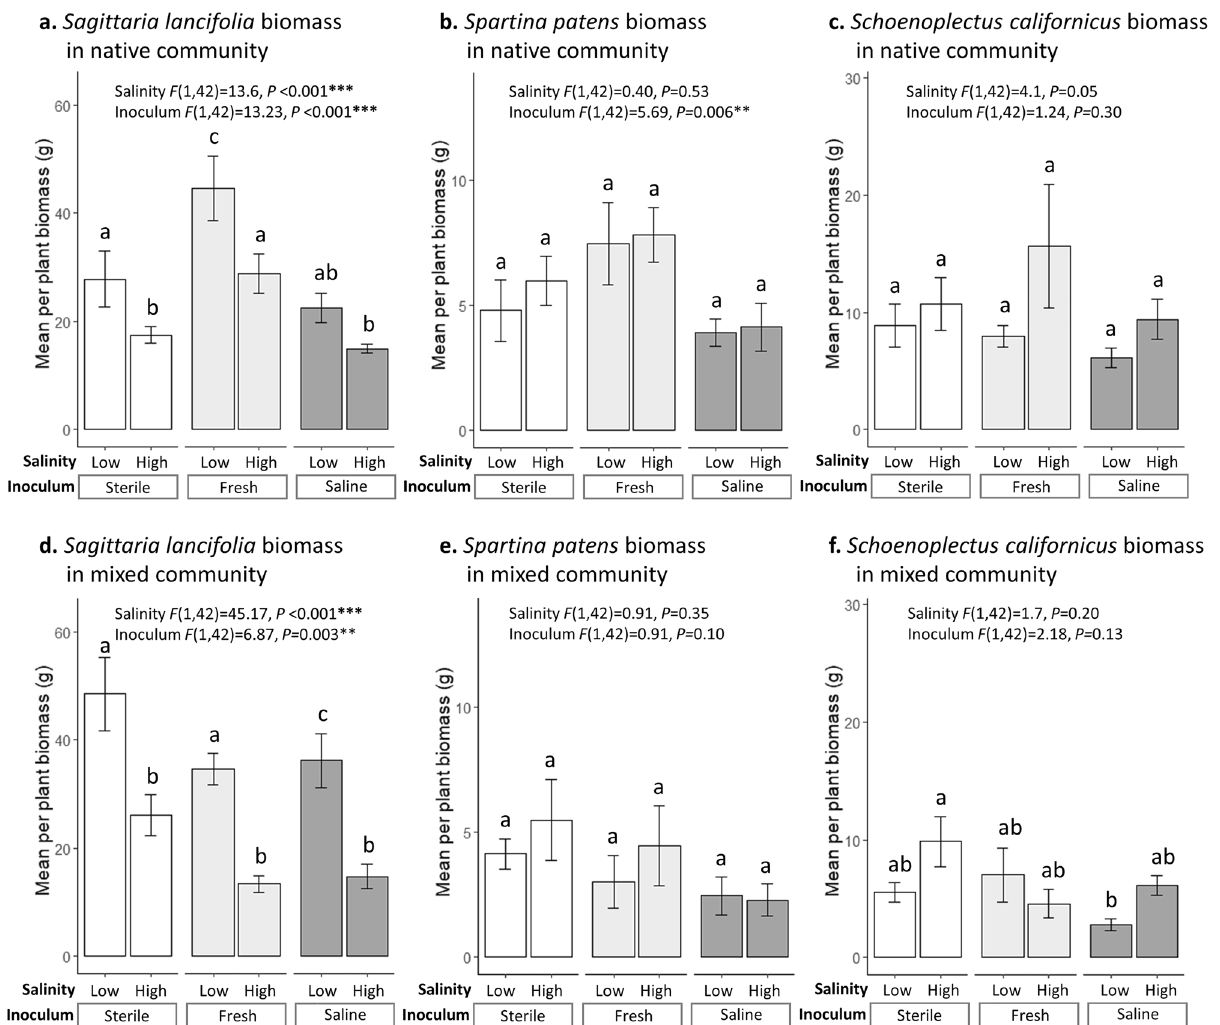
Figure 2. Effects of salinity (low and high) and inoculum (sterile, freshwater, and saline) on native species biomass in native communities ( a – c ) and mixed communities ( d – f ). White bars represent sterile soils, light grey bars represent freshwater inoculum treatments, and dark grey bars represent saline inoculum treatments. Error bars represent 1 standard error of treatment means. Two-way ANOVA results are presented. The salinity*inoculum interaction term was not significant, so it was not included in final models. Letters over the bars represent differences in means from Tukey post hoc tests. To compare biomass in different community types, total pooled biomass was adjusted to represent biomass per plant. There were two plants per species in the native communities, so total biomass per species was divided by two. There was only one plant per species in the mixed communities, so it was not